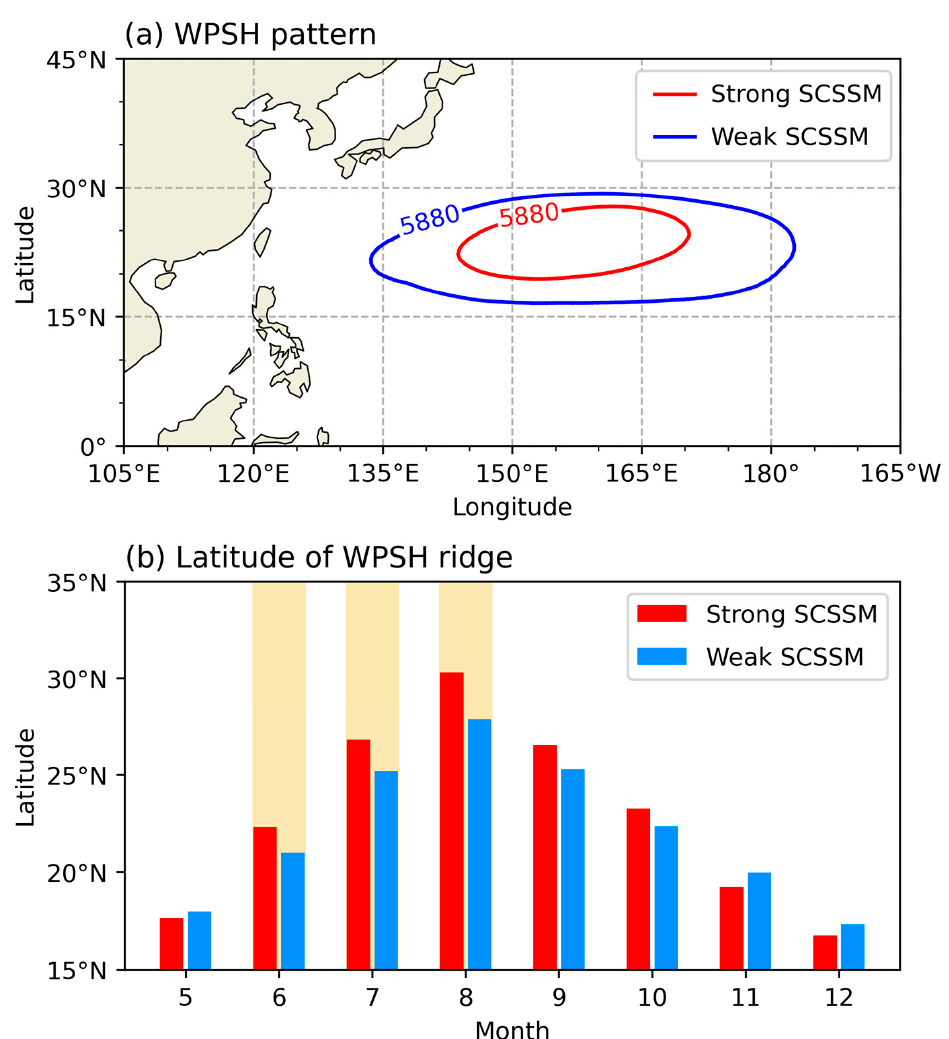
Figure 7. ( a ) The patterns (unit: gpm) and ( b ) the ridge latitudes of Western Pacific subtropical high (WPSH) at 500 hPa over the WNP basin during TC season (May to December), in which strong SCSSM years are in red and weak SCSSM years are in blue, with yellow shading in ( b ) indicating that the differences are significant at 90% confidence level.